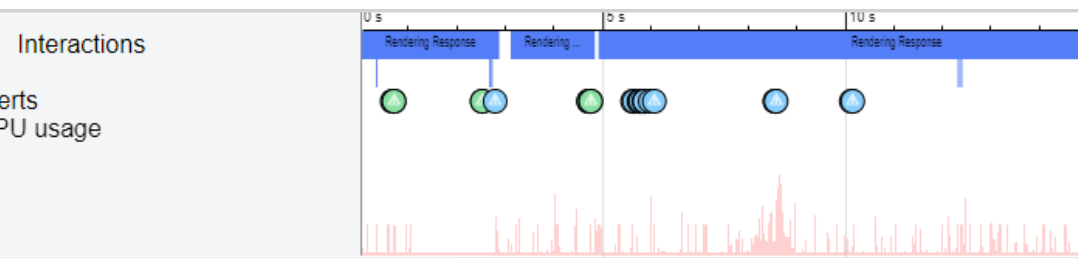
Figure 8. Alert states that indicate performance issues while rendering the relevant frames, provided by Android‘s Systrace analysis